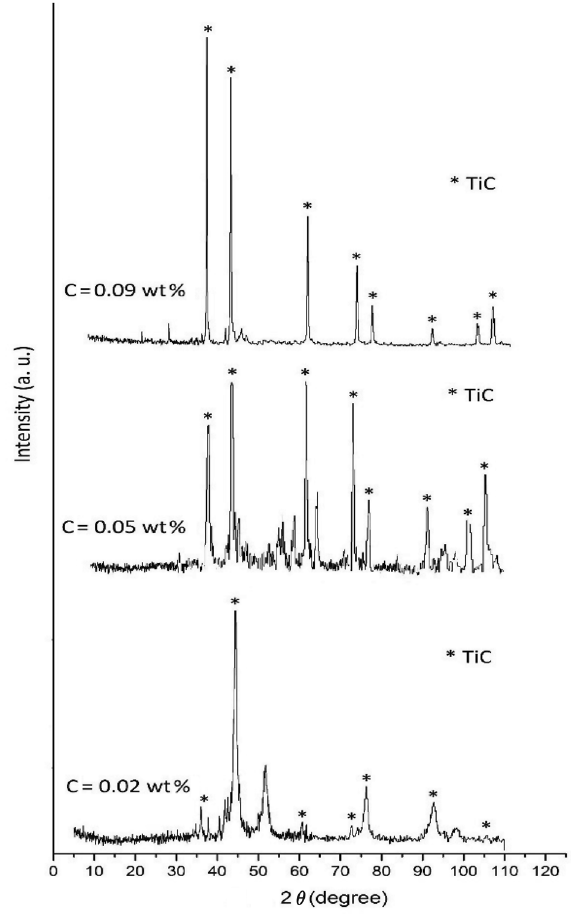
Figure 2: XRD patterns of the extracted carbides for alloys with various amounts of